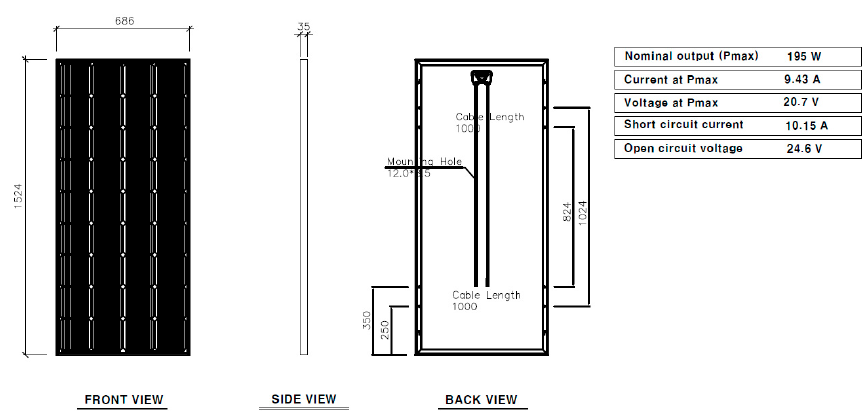
Figure 13. Bifacial-panel specification (Section D).